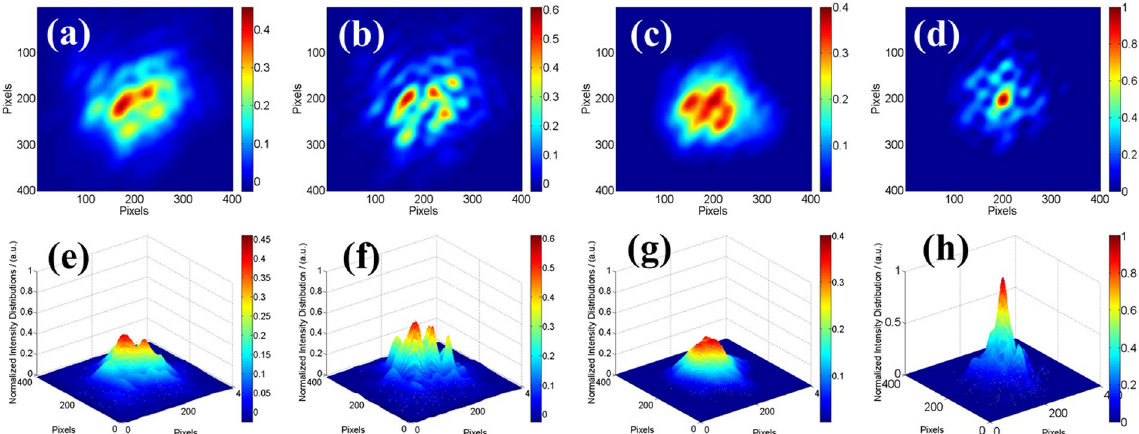
Figure 9. Long exposure beam intensity distribution patterns in different situations. Top row: Two dimensional intensity distributions. Bottom row: Three dimensional intensity distributions. ( a and e ) Open loop, ( b and f ) Only the phase-locking control is on, ( c and g ) Only the end-cap/tilt control is on, (d and h ) Closed